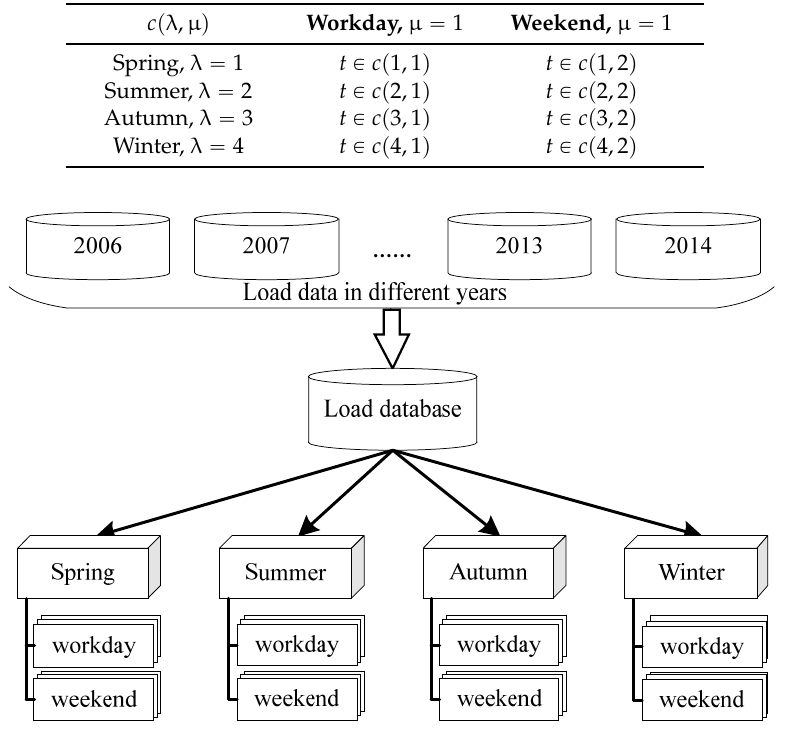
Figure 3. Load grouping process. Table 1. Groups of load.